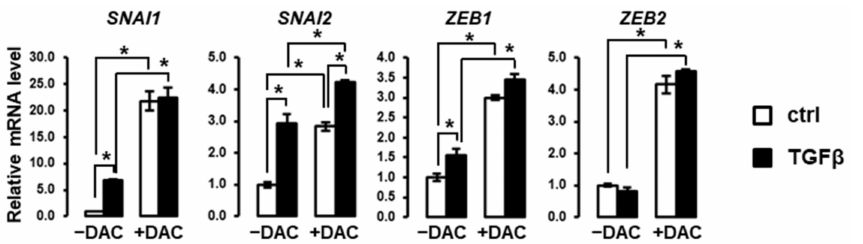
Figure 4. Decitabine enhances the expression of EMT-associated transcription factors. Expression analysis was performed in SNU449 cells treated with TGF β (black bars) versus control (white bars) in the absence (left 2 bars) or presence (right 2 bars) of decitabine (DAC). SNU449 cells were treated alone or in combination with 1 ng/mL TGF β 1 and 100 µ M decitabine (DAC) for 24 hrs. * p <